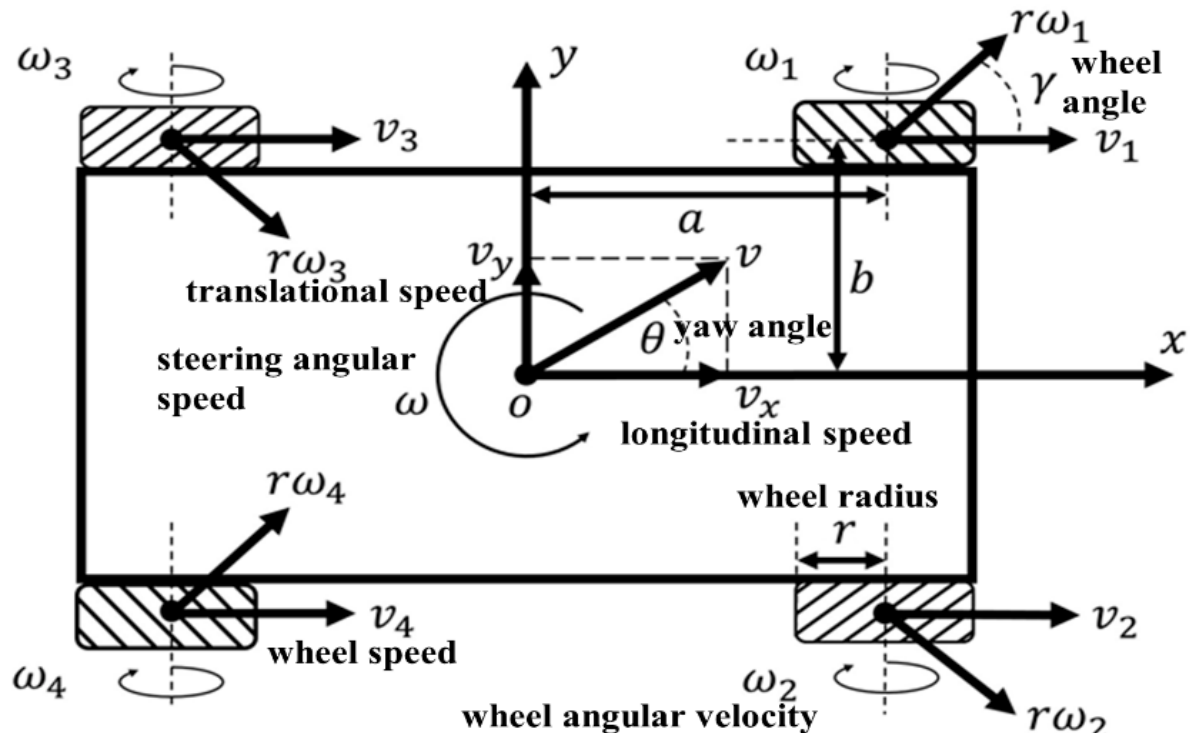
Figure 1. The configuration of the omnidirectional Mecanum-wheeled automated guided vehicle.